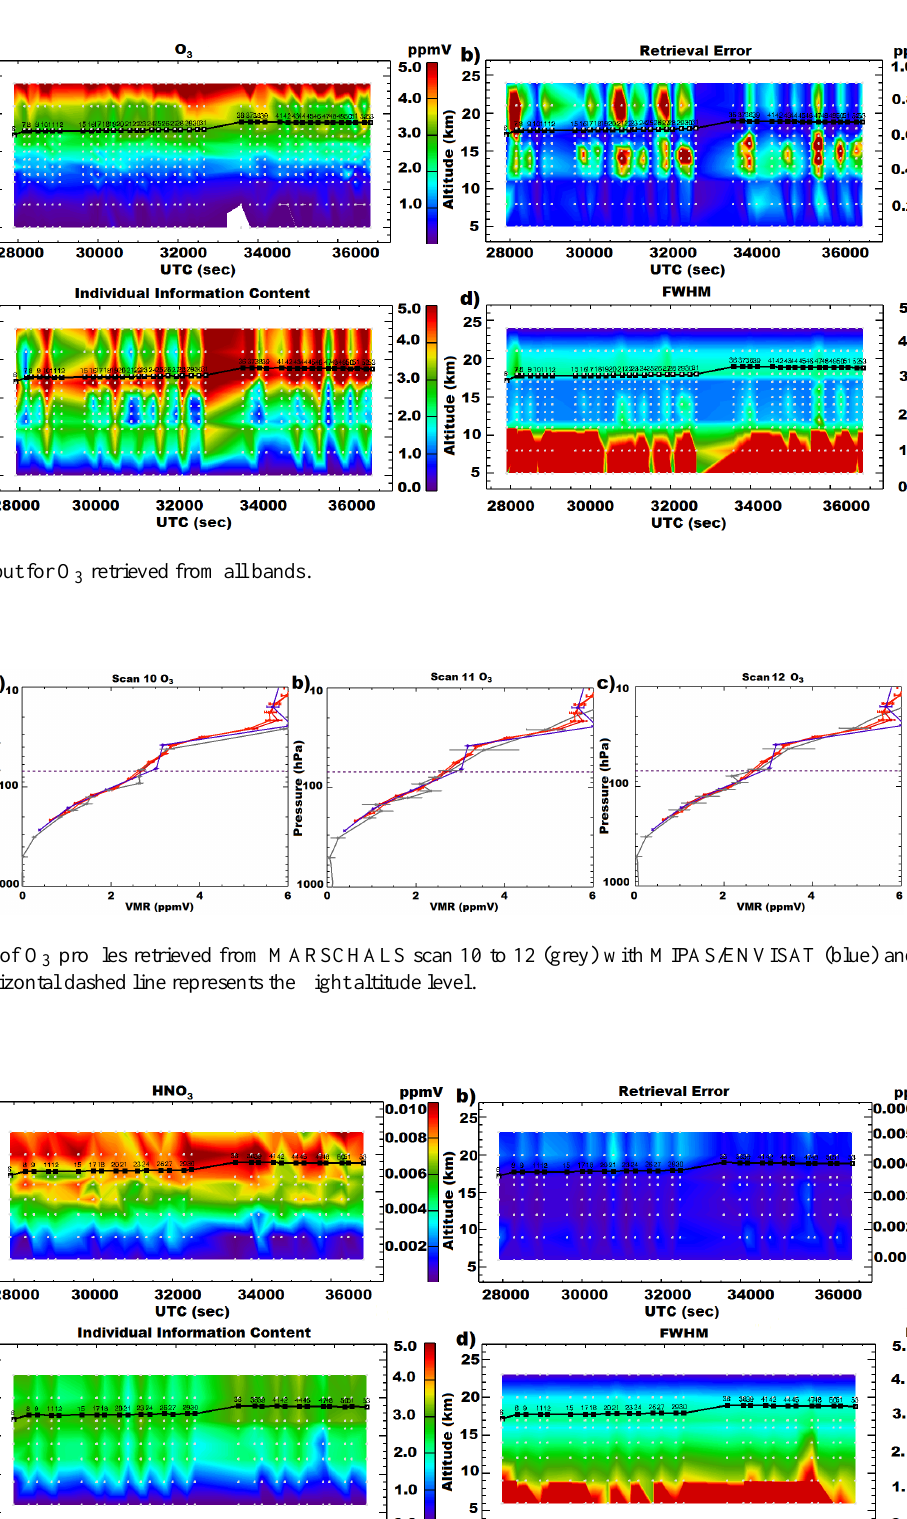
retrieved from band C and D. 3